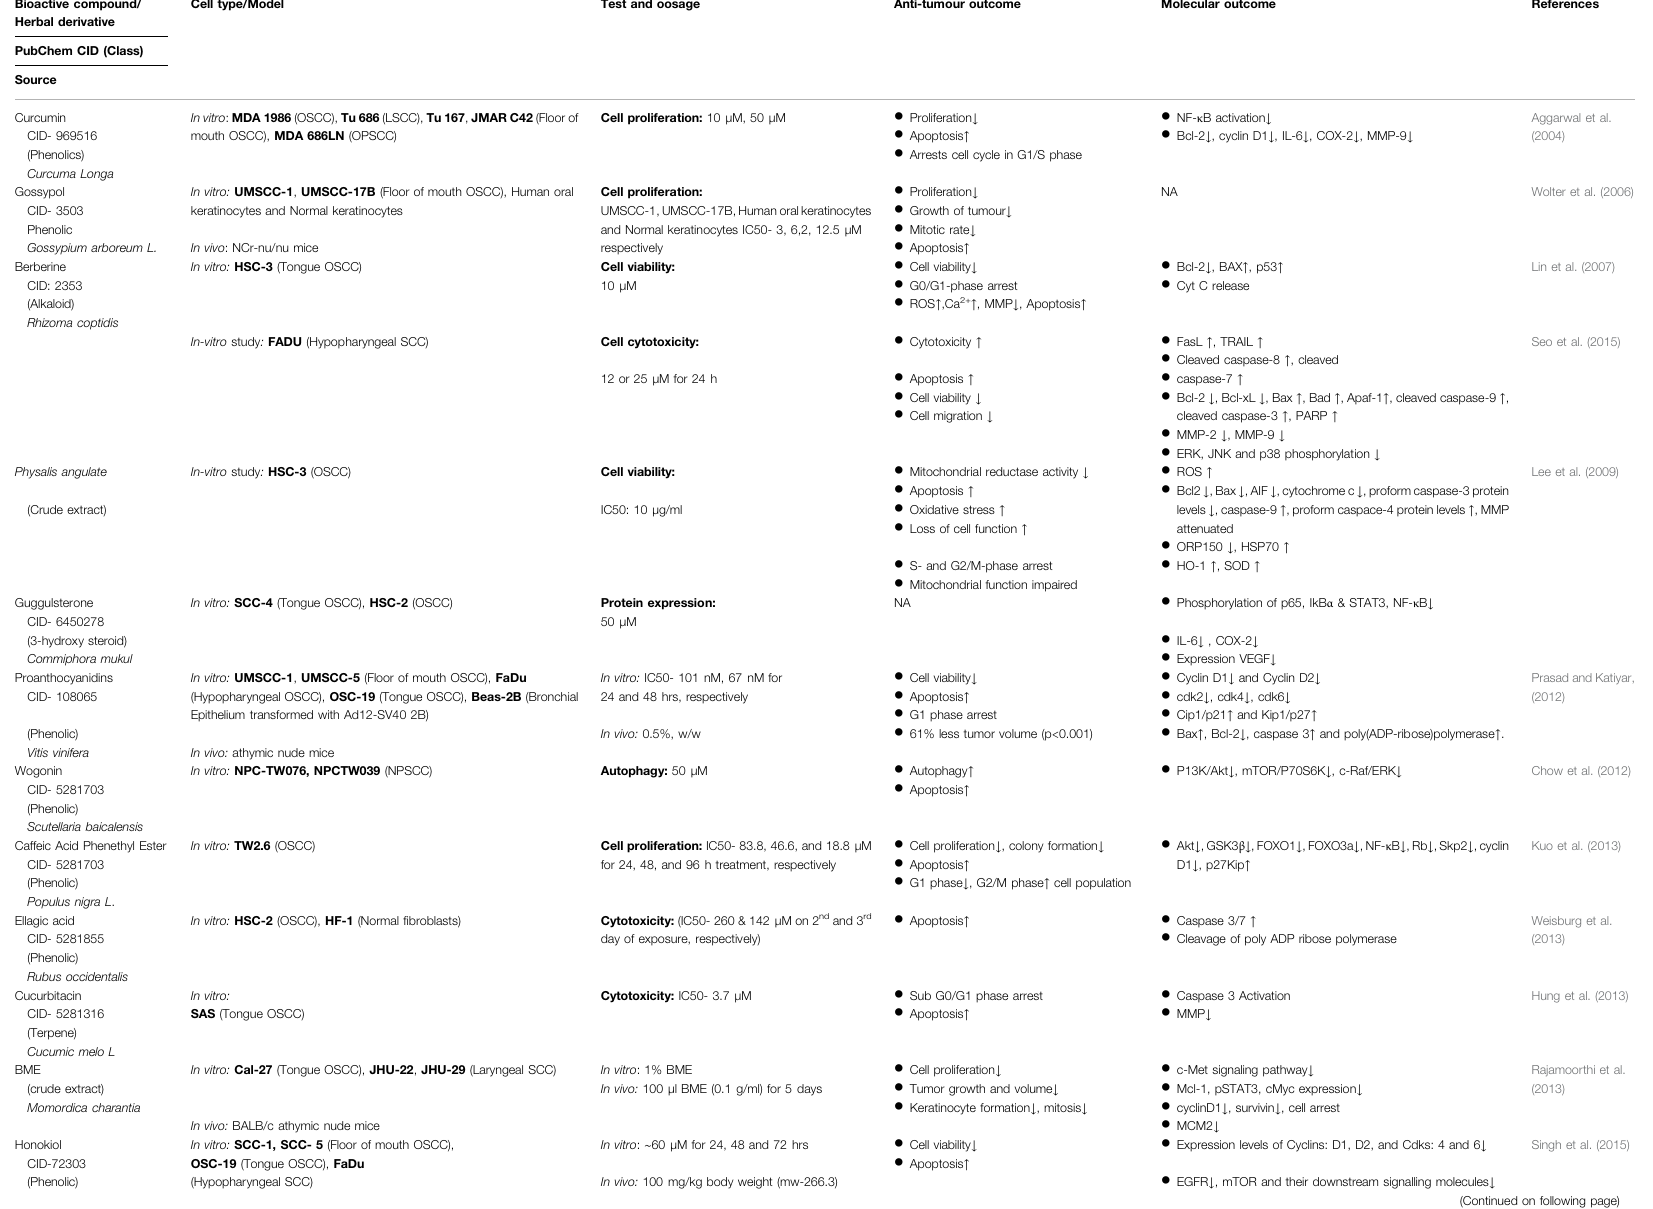
TABLE 4 | Preclinical studies showing therapeutic phytochemicals/herbal derivatives against tobacco/alcohol-associated HNC. Bioactive compound/ Herbal derivative